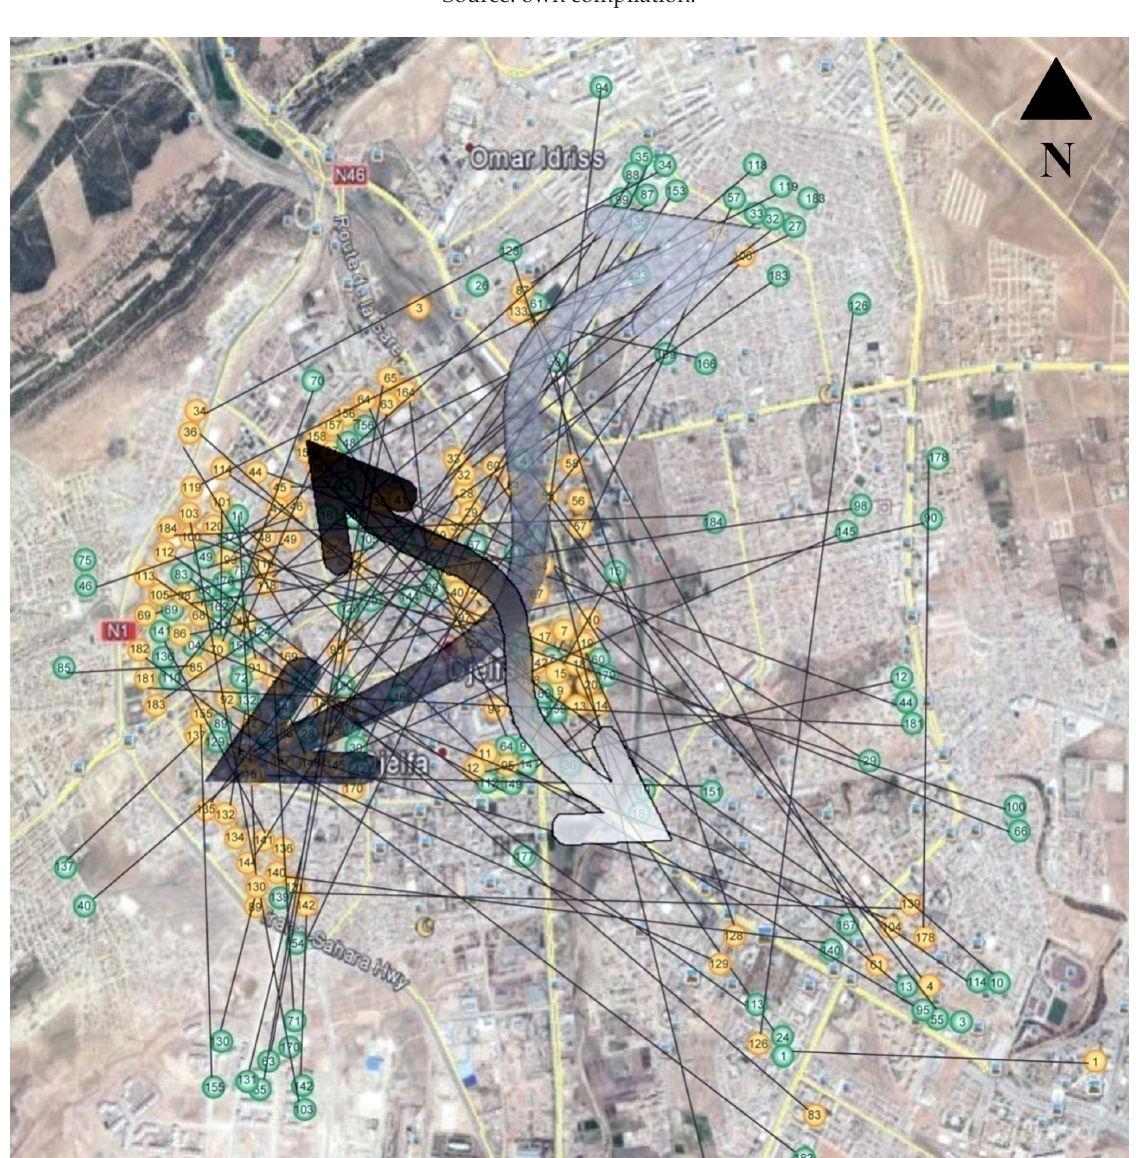
Fig. 8. Mesh representing home-to-work trips. Green colour – homes; yellow colour – workplaces; grey arrows – the main directions for commuting. Markings are carried out in Google earth (2015). Source: own